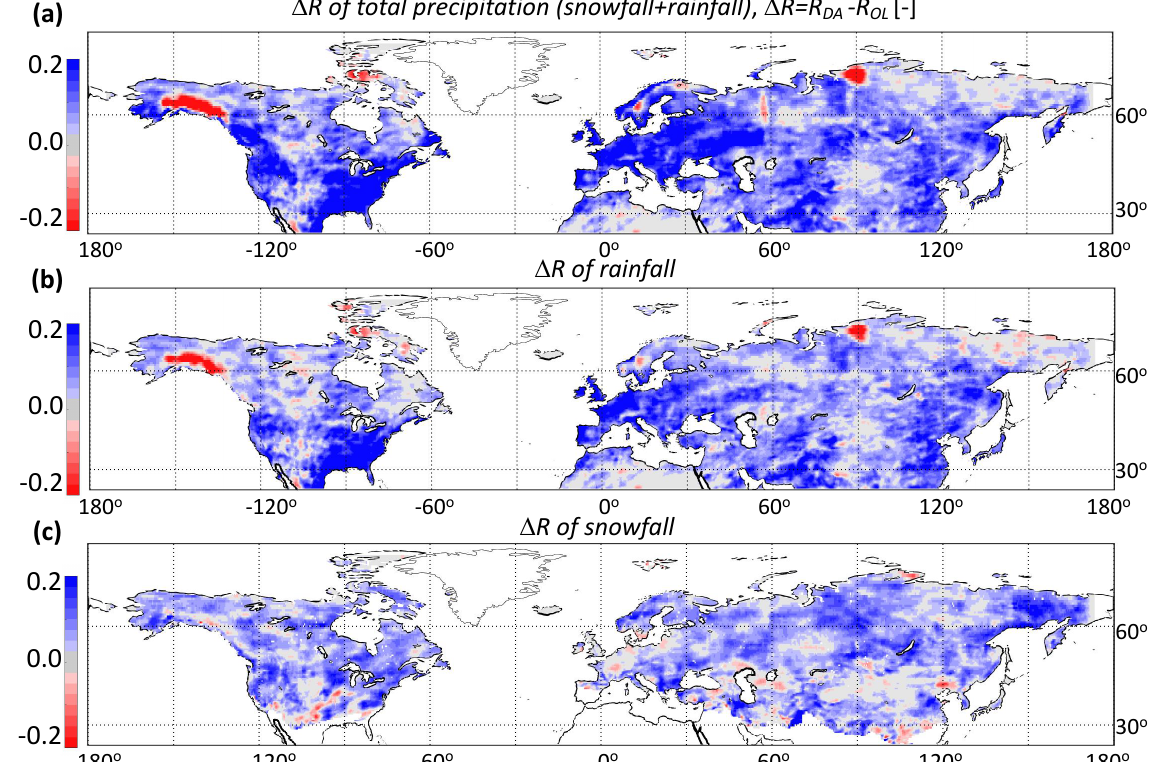
Figure 6. Difference in correlation skill ( ∆ R ) between data assimilation (DA) and open-loop (OL) for ( a ) total precipitation, ( b ) rainfall, and ( c ) snowfall, taking the synthetic precipitation as “truth”. The assimilation of TWS increases the skill over nearly the entire domain, except along the Gulf of Alaska and in the Yenisei River Delta. Only snow-possible areas as indicated in ([56]) are reported in ( c